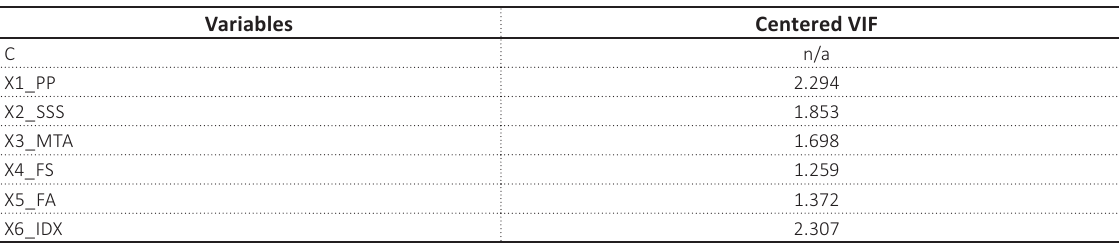
Table A5. Multicolinearity test